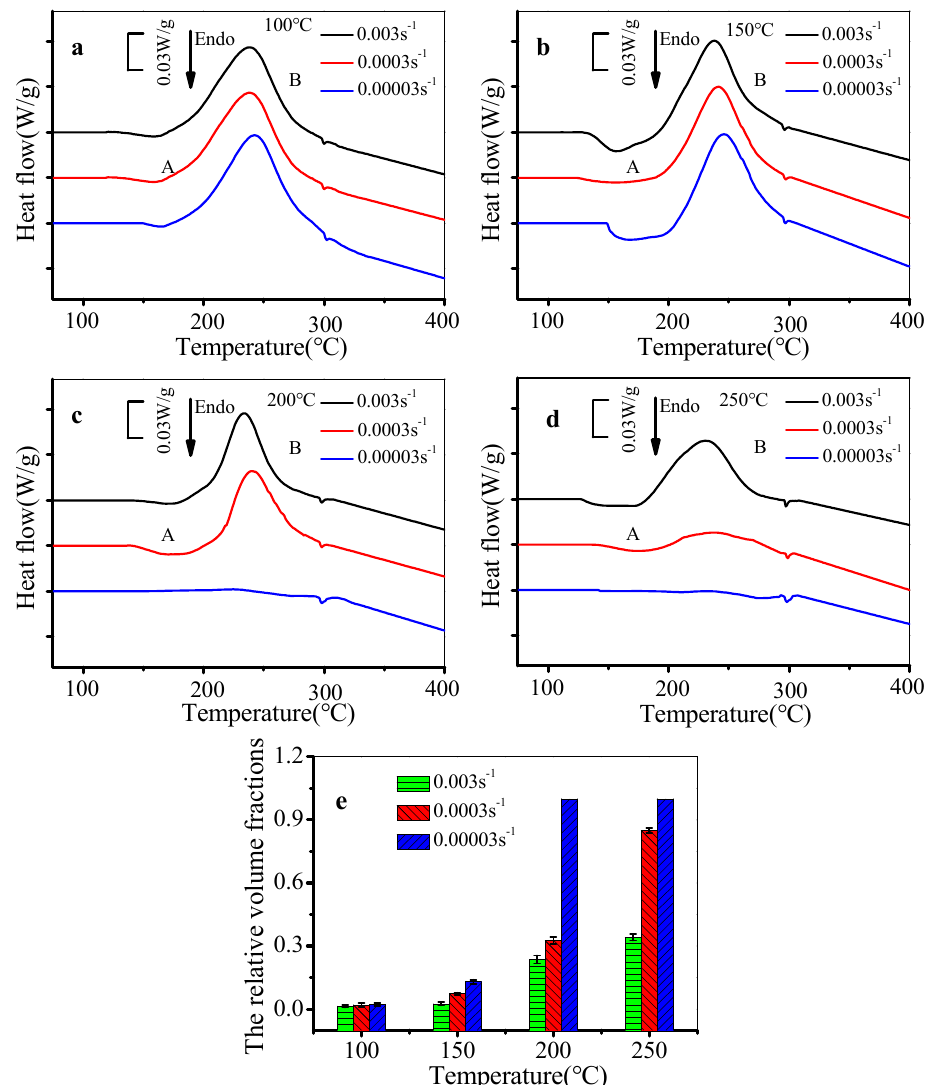
Figure 9. DSC curves and the relative volume fraction (RVF) of θ′ phases of the stretched alloy at ( a ) 259 100 °C, ( b ) 150 °C, ( c ) 200 °C, and ( d ) 250 °C. ( e ) The RVF of θ′ phases. 260